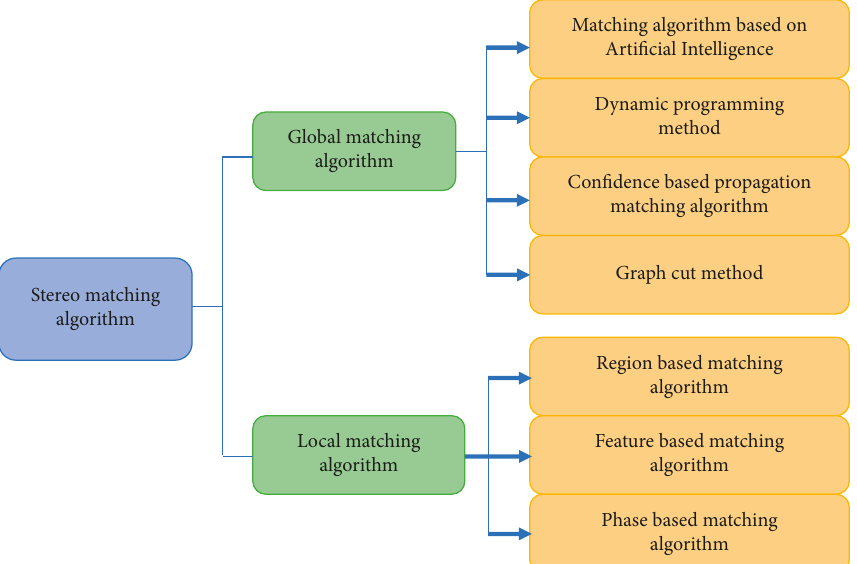
Figure 8: Classification of stereo matching